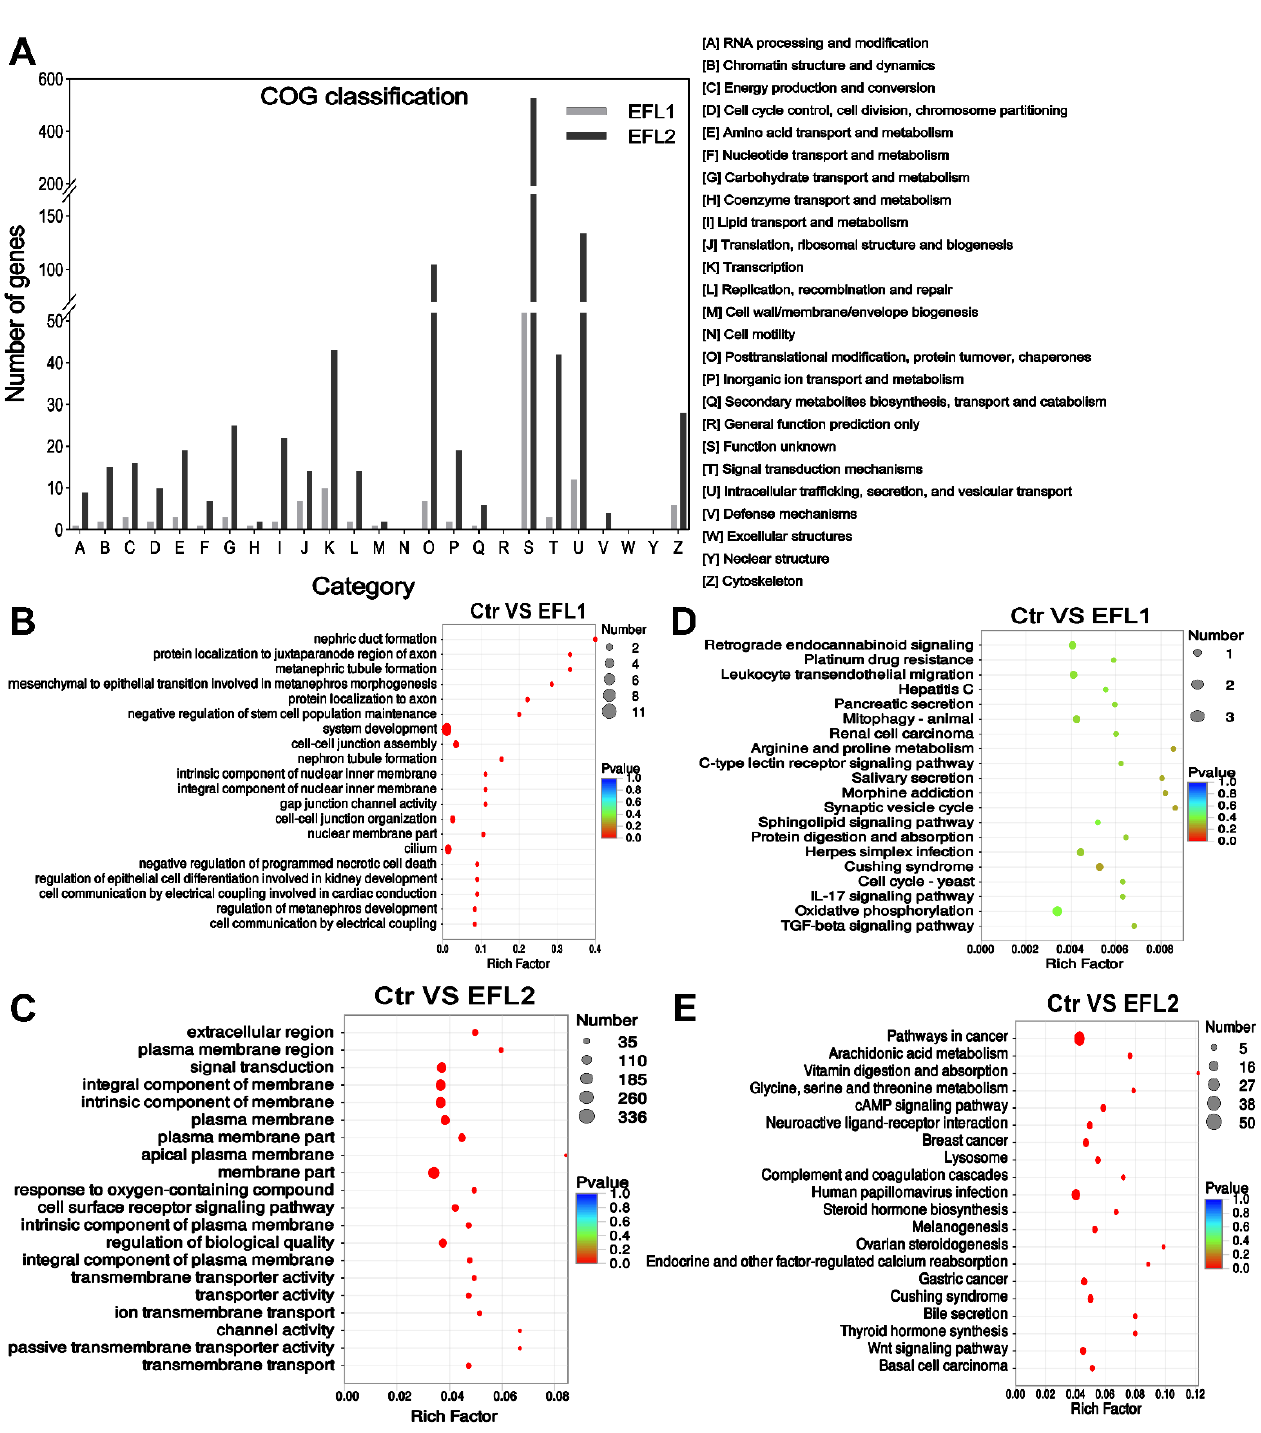
Figure 3. ( A ) The COG classification of differentially expressed mRNA in EFL-treated Caco-2 cells. ( B ) GO and ( C ) KEGG annotation of the differentially expressed mRNA in the EFL1 group. ( D ) GO and ( E ) KEGG annotation of the differentially expressed mRNA in the EFL2 group.